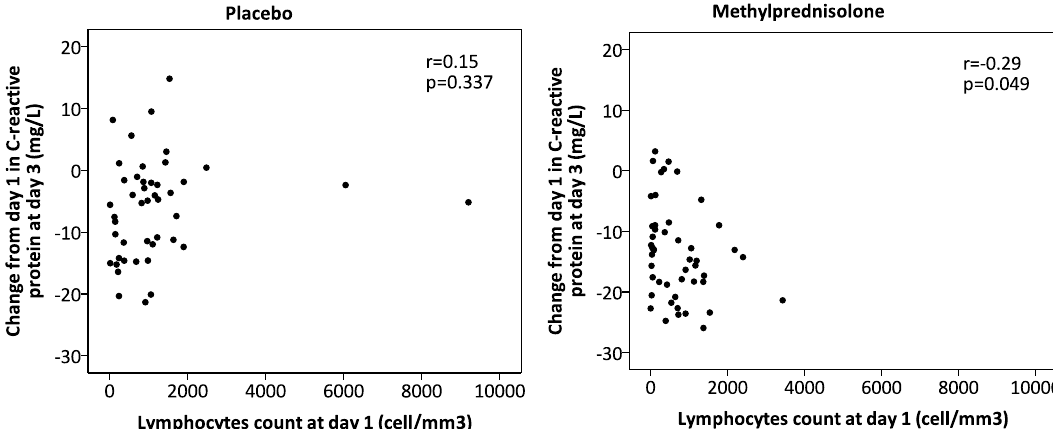
Figure 1. Correlation between the change from day 1 in C-reactive protein at day 3 and lymphocyte count at day 1 for the per protocol population.